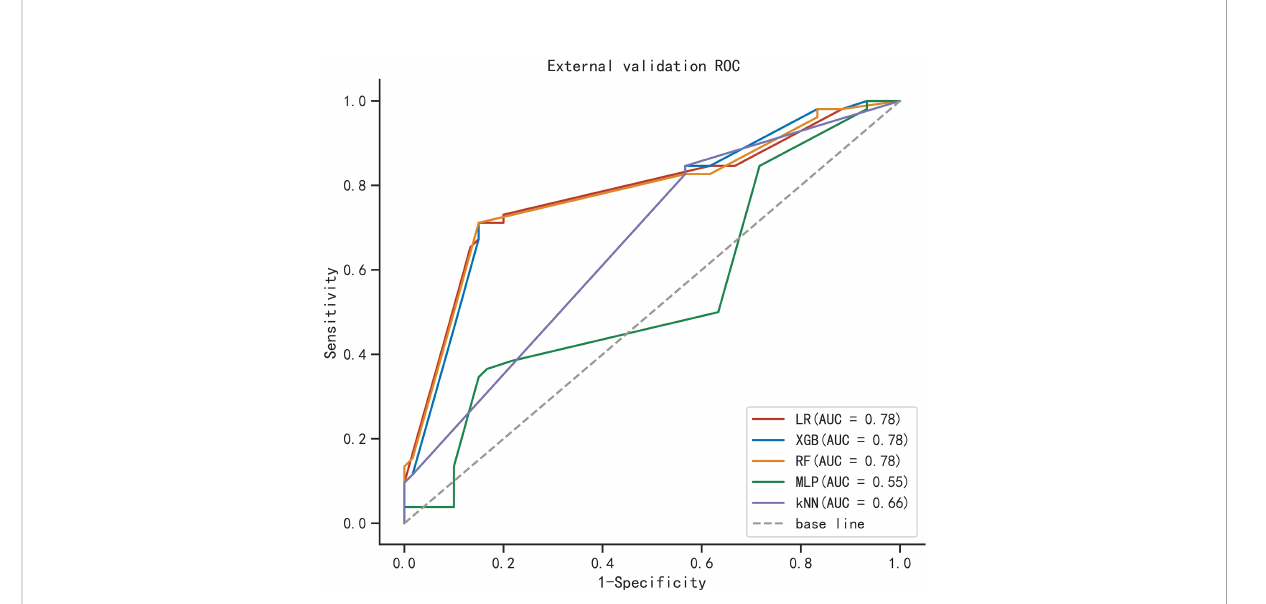
FIGURE 3 ROC curve analysis of fi ve machine learning algorithms for predicting the risk of PCa in the external